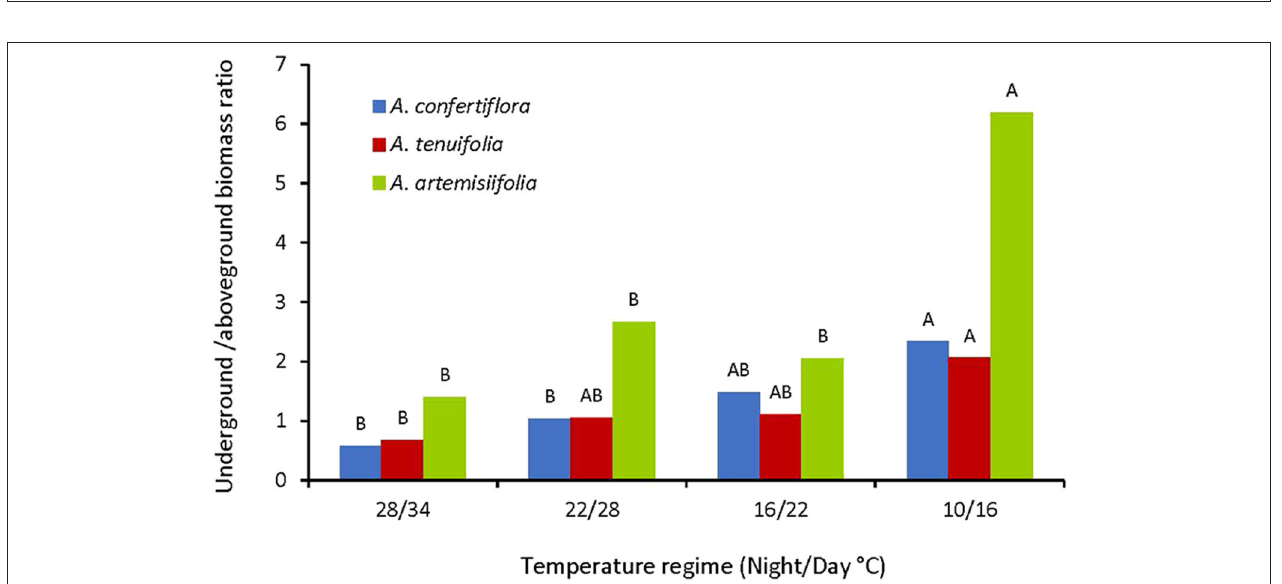
FIGURE 8 | Effect of temperature regimes on underground/aboveground biomass ratio of A. artemisiifolia, A. confertiflora, and A. tenuifolia 121 DAS. Same colored bars topped with a same letter are not significantly different according to Tukey-Kramer HSD, p = 0.05.